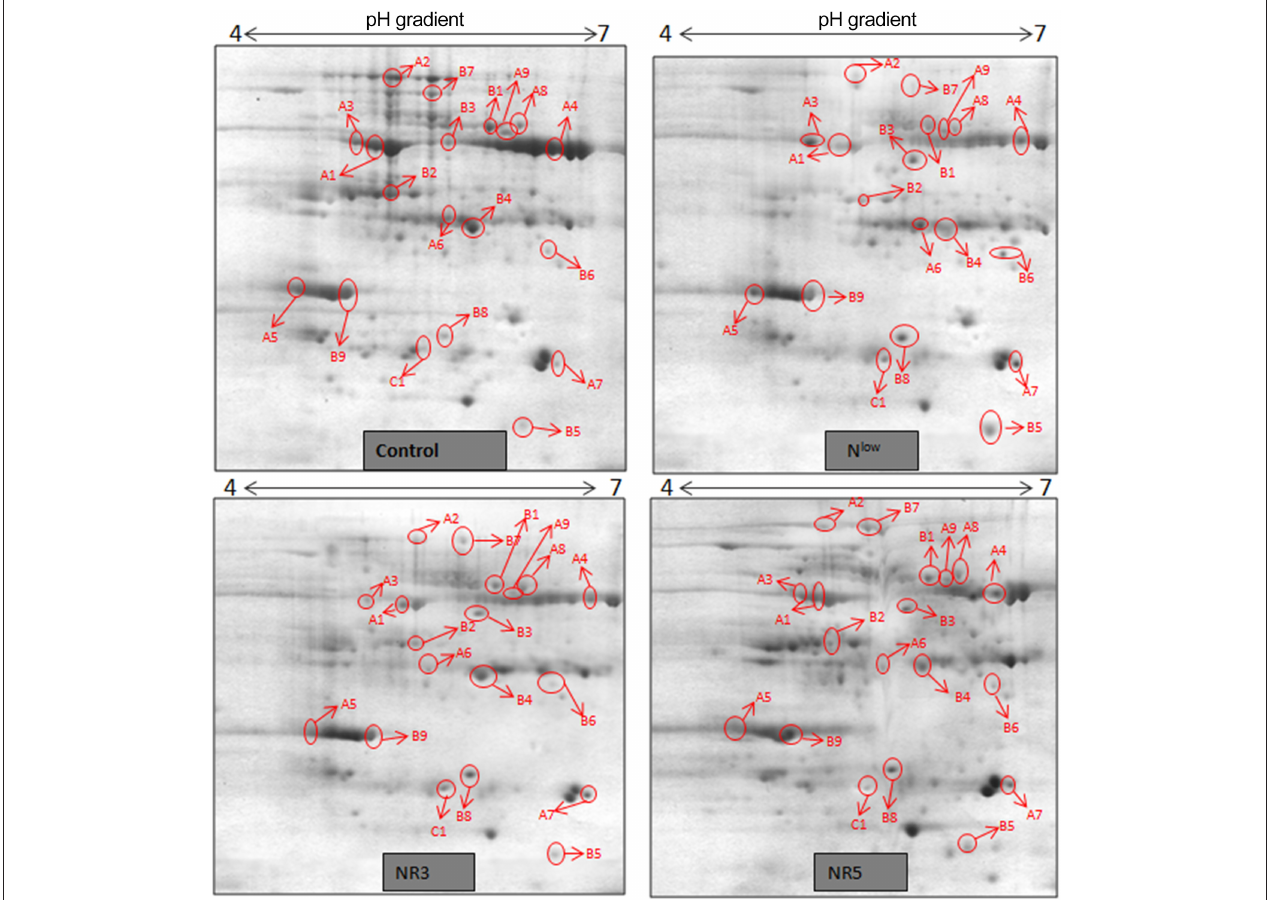
FIGURE 4 | 2DE maps representing differential protein intensities between different N treatments of HM-4.